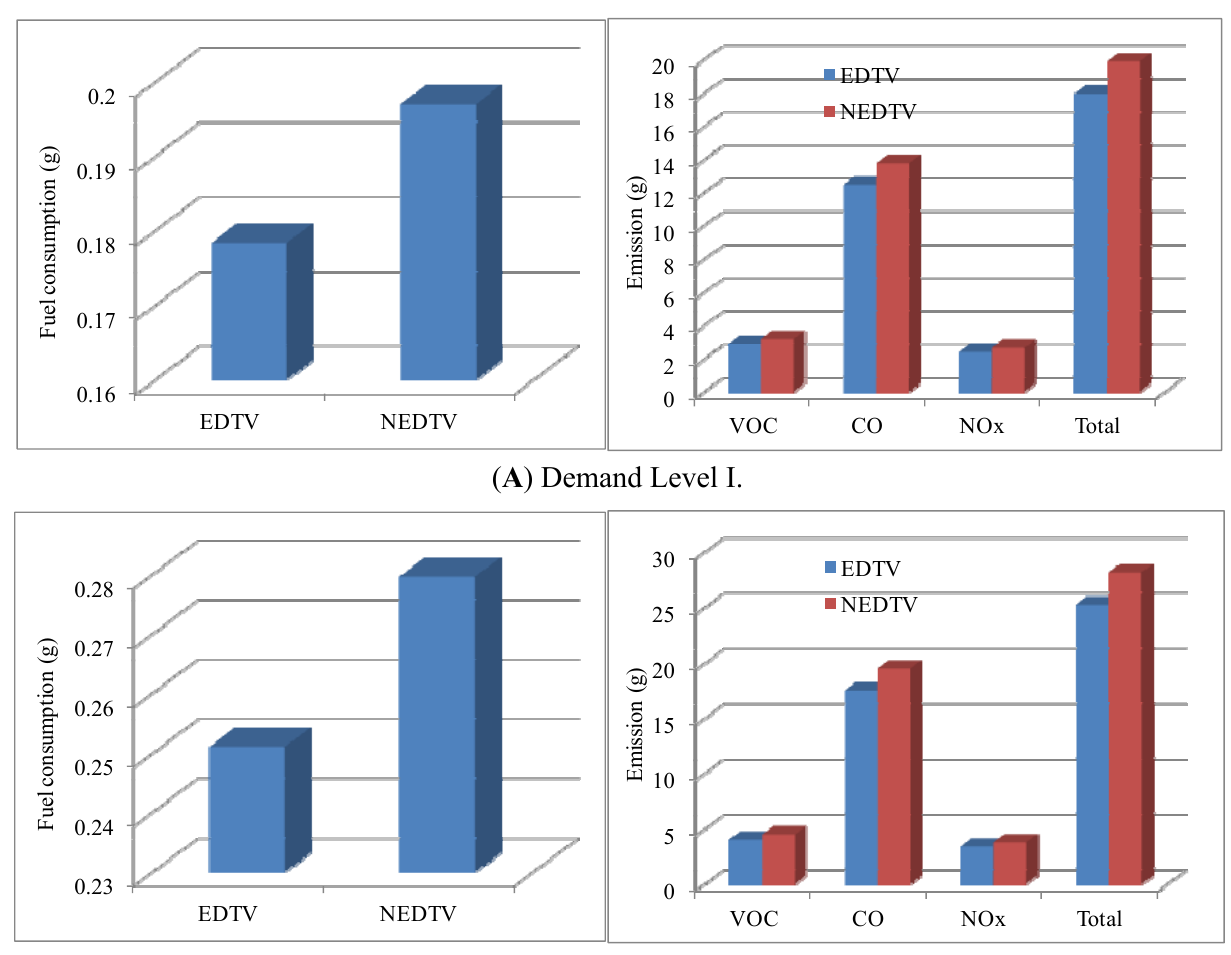
Figure 5. Bus fuel consumption and pollution emission under different traffic